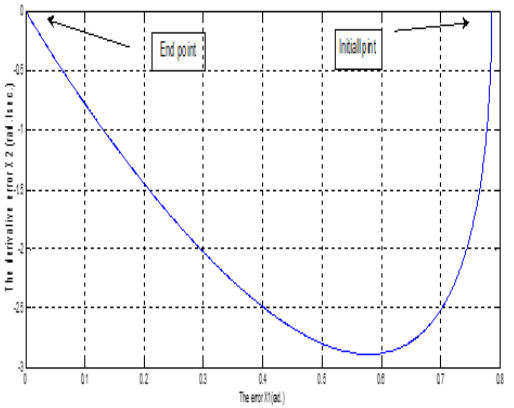
vs. time of the ISMC.